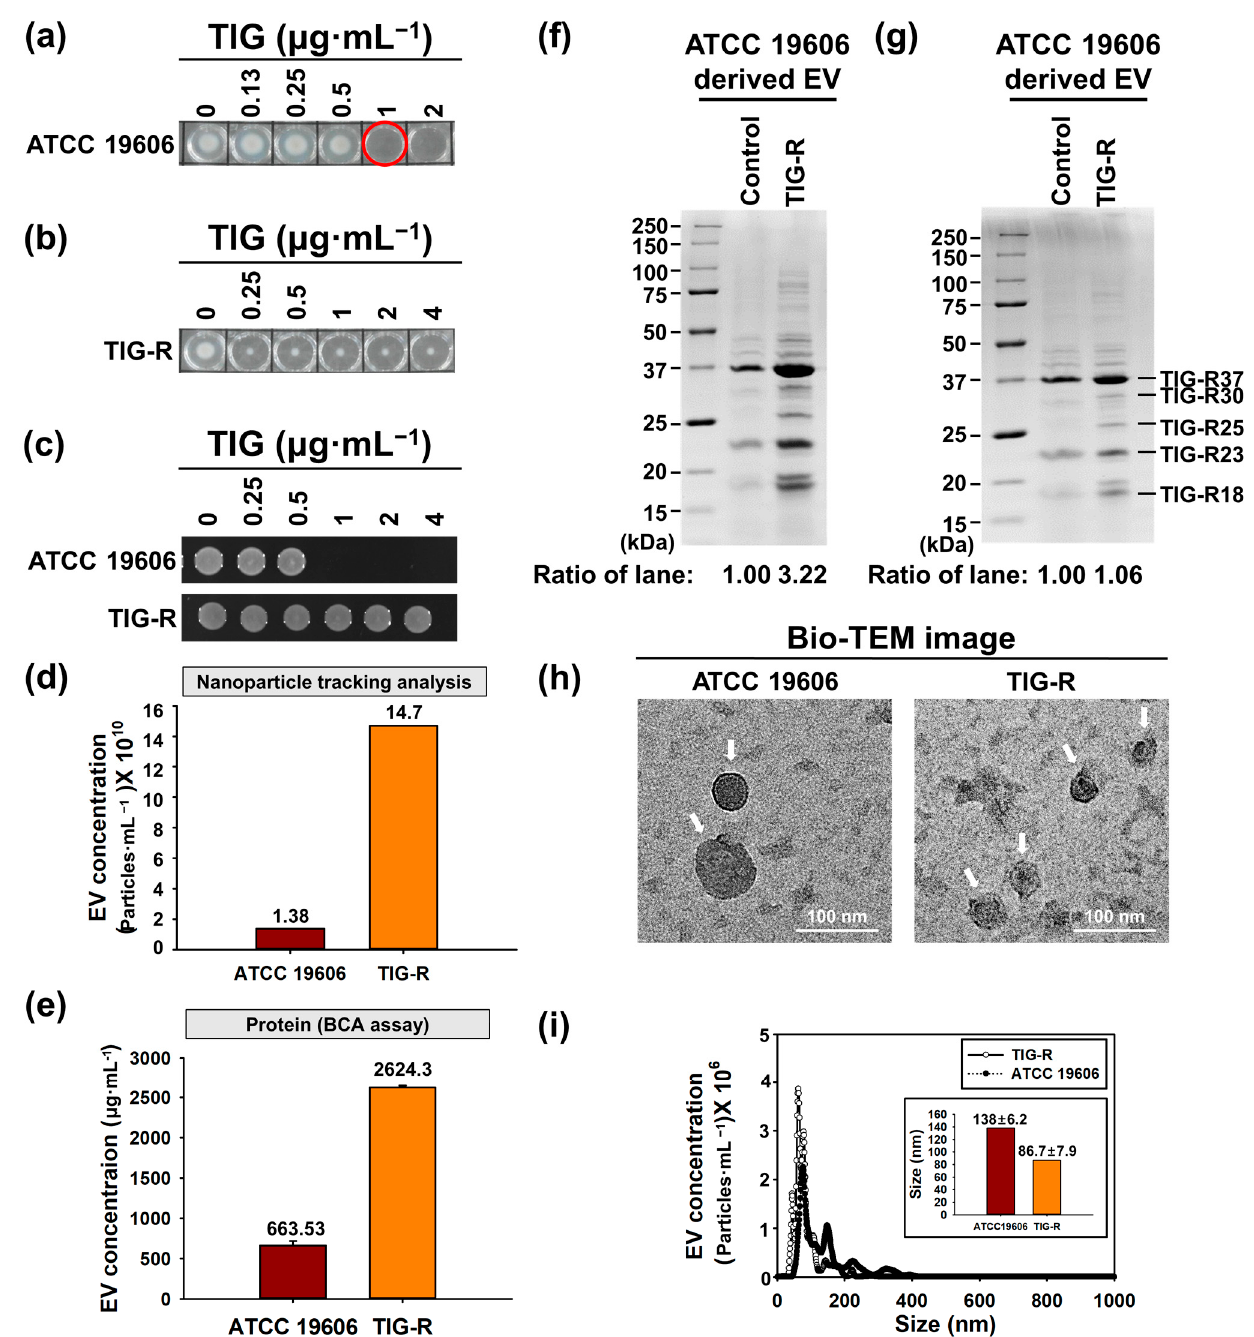
Figure 1. Characterization of strains and EVs produced from ATCC 19606 and TIG-R. ( a , b ) MIC determination of TIG-S AB (ATCC 19606) and TIG-R AB strains against TIG (0–4 µ g · mL − 1 ). Red circle of the plate indicated MIC for TIG. ( c ) Cell viability. Aliquots (5 µ L) from ( a , b ) were spotted on. EVs were quantified by ( d ) NTA, ( e ) BCA assay ( µ g · mL − 1 ), and protein gel electrophoresis (12% Mini-PROTEAN®TGX TM Stain-Free gel) of EVs with the equivalent amount by ( f ) OD 600 or ( g ) 10 µ g of protein quantified by BCA assay. As a size marker, Precision Plus Protein TM Standards (Bio-Rad, Hercules, CA, USA) was used. The morphology of EVs was analyzed using ( h ) TEM image analysis and the size was determined by ( i ) NTA using the same amount of BCA assay quantified EVs. LB-agar plates and protein bands were imaged by ChemiDoc TM MP Imaging System (Bio-Rad, Hercules, CA, USA) and Image Lab Software (ver.5.2.1, Bio-Rad, Hercules, CA,